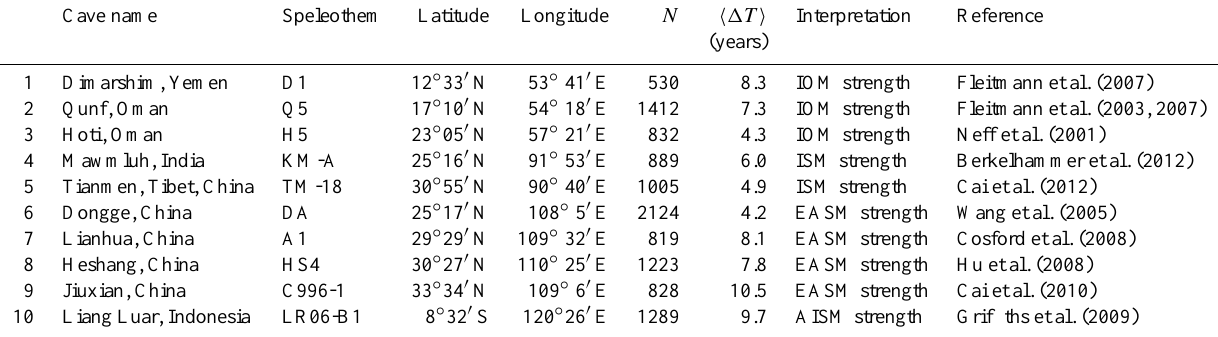
Table 1. List of speleothem δ 18 O oxygen isotope records used in this study including cave name, speleothem ID, cave location, number of data points N , average sampling time (cid:104) (cid:49)T (cid:105) , and climatological interpretation (IOM, Indian Ocean monsoon; ISM, Indian summer monsoon; EASM, East Asian summer monsoon; AISM, Australian–Indonesian summer monsoon. From the Mawmluh record, all data points prior to 9kaBP were discarded, since the older part of the record was recently found to be insufficiently dated (M. Berkelhammer, personal communication,